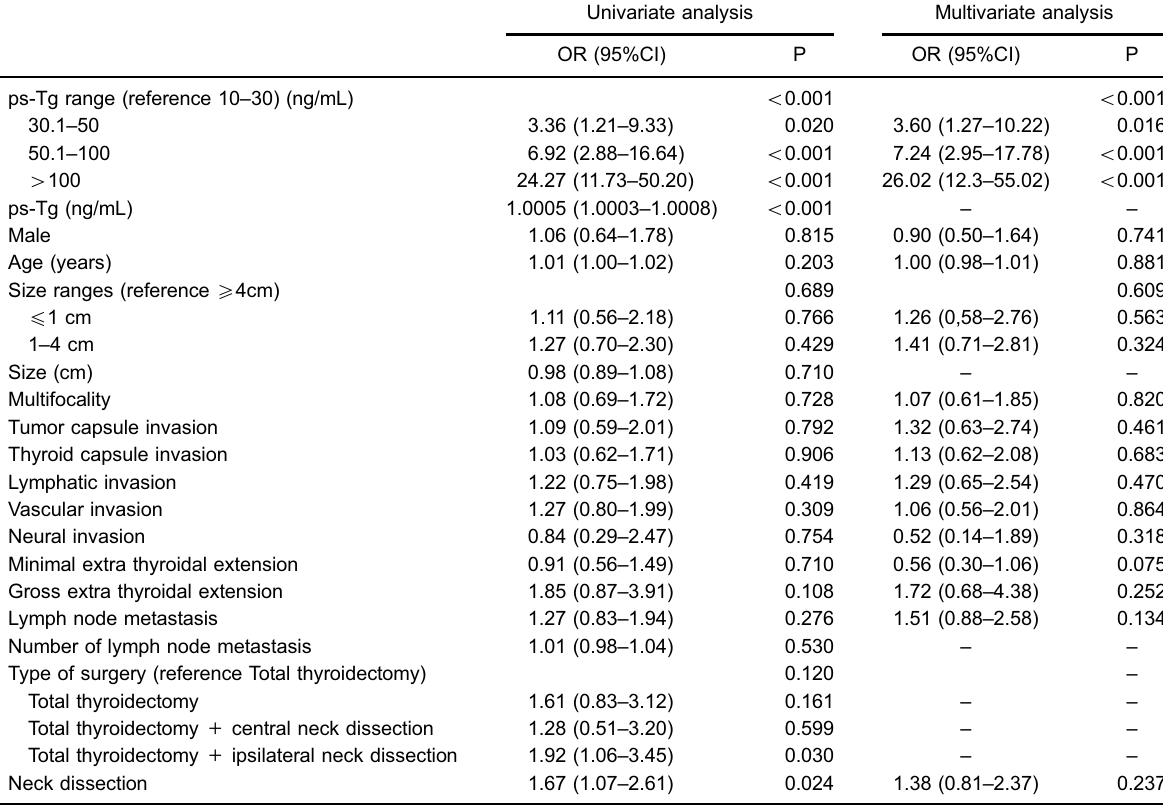
Table 2. Prognostic factors for distant metastases in patients with differentiated thyroid cancer.